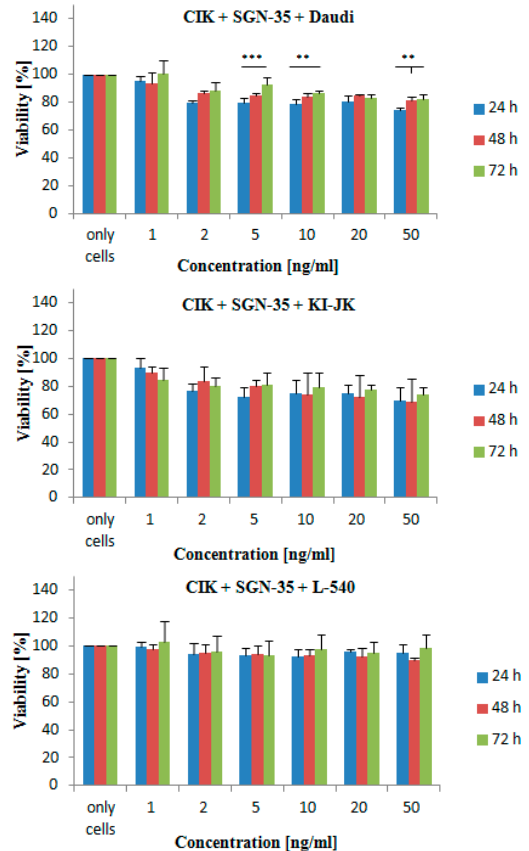
Figure 3. Effect of SGN-35 on the cytotoxicity of the CIK cells after 24, 48 and 72 h. The cytotoxic effect of the CIK cells was tested on the cell lines Daudi , KI-JK and L-540 at a 1:1 ratio. The cell viability was measured using an MTT assay. Results represent data from three separate experiments with three triplicates for each probe. Data are presented as mean ± SD ( p < 0.05). One asterisk indicates a p- value of 0.04 to 0.05, two asterisks indicate a p- value of 0.02 to 0.03 and three asterisks a p- value of <0.02.